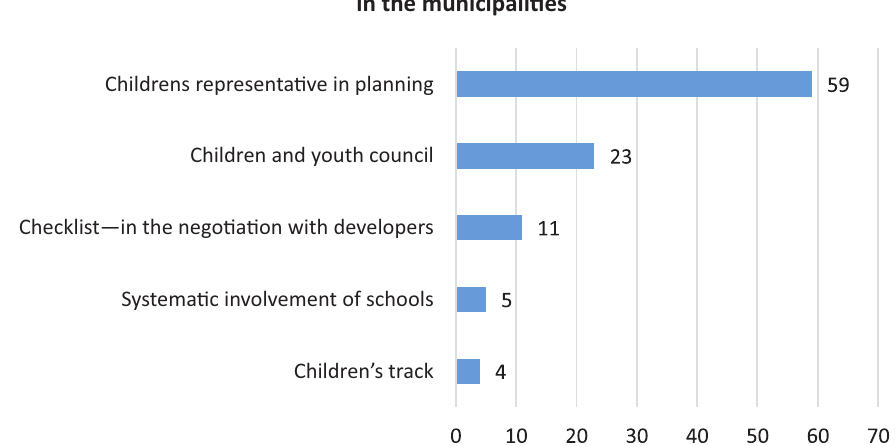
Figure 3. The type of arrangements that are found in the municipalities. Notes: Percentage (many alternatives allowed); N = 159; data from